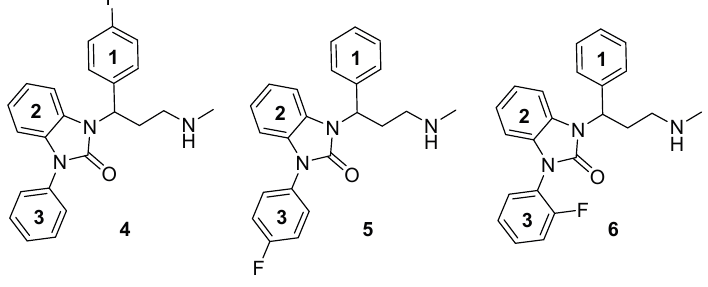
Figure 2. Chemical structure of envisaged reference compounds 4 – 6